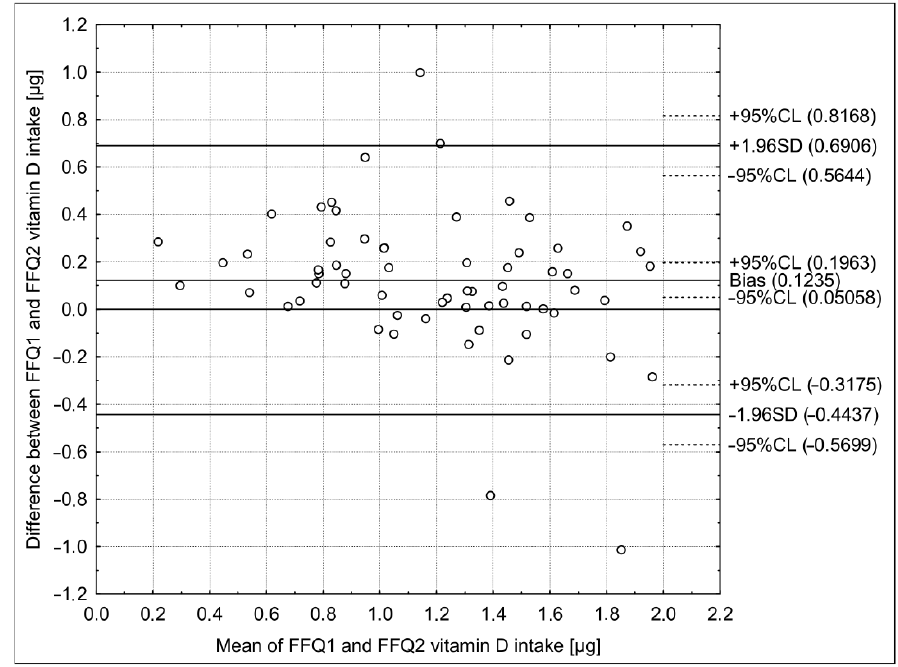
Figure 3. The Bland-Altman plot in the assessment of reproducibility of the Cro-VIDEO-FFQ questionnaire (Bland-Altman index of 6.3%, due to 59 out of 63 individuals within the limit of agreement). Cro-VIDEO-FFQ1—the food frequency questionnaire to assess vitamin D intake in the first stage Cro-VIDEO-FFQ2—the food frequency questionnaire to assess vitamin D intake in the second